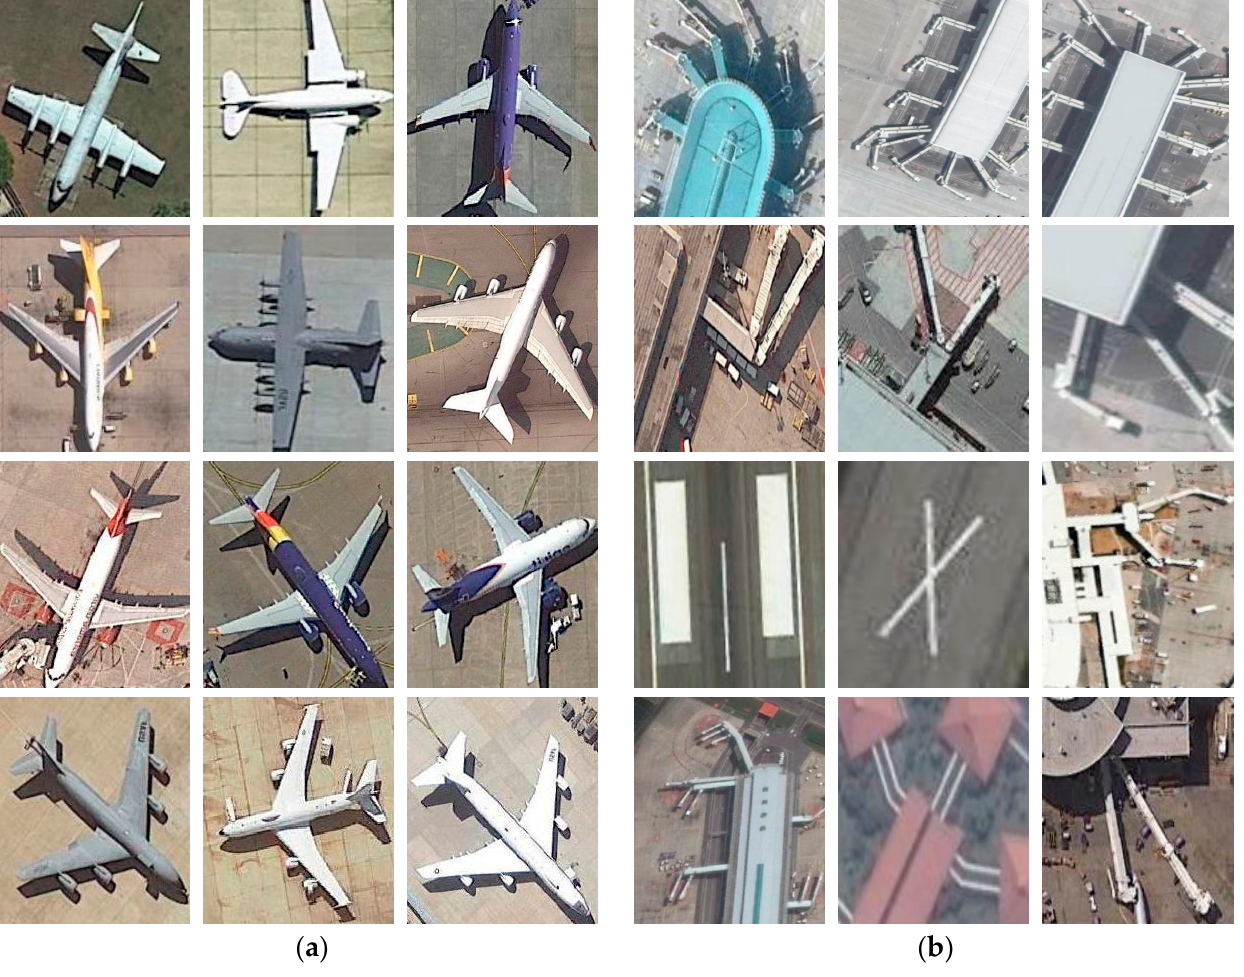
Figure 6. Subsets of binary classification network dataset. ( a ) Positive samples. ( b ) Negative samples.